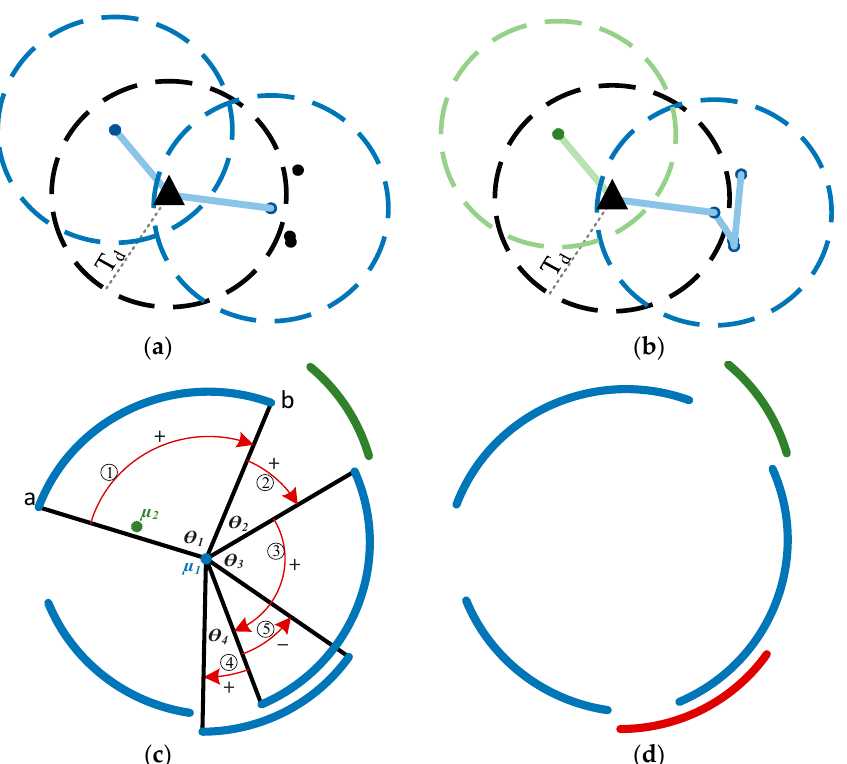
Figure 8. Schematic diagram of the local clustering search strategy and rotation direction judgment condition. ( a ) is to find the closest point from the point of interest, ( b ) is divided into two categories according to the search range and radius, ( c ) is the judgment of the false classification segment according to the rotation direction and rotation angle, ( d ) is the final contour grouping. Different groups are a different color, the dotted line is the local search range, the red arrow indicates the direction of rotation, and ( θ 1 , θ 2 , θ 3 , θ 4 ) is the angle of